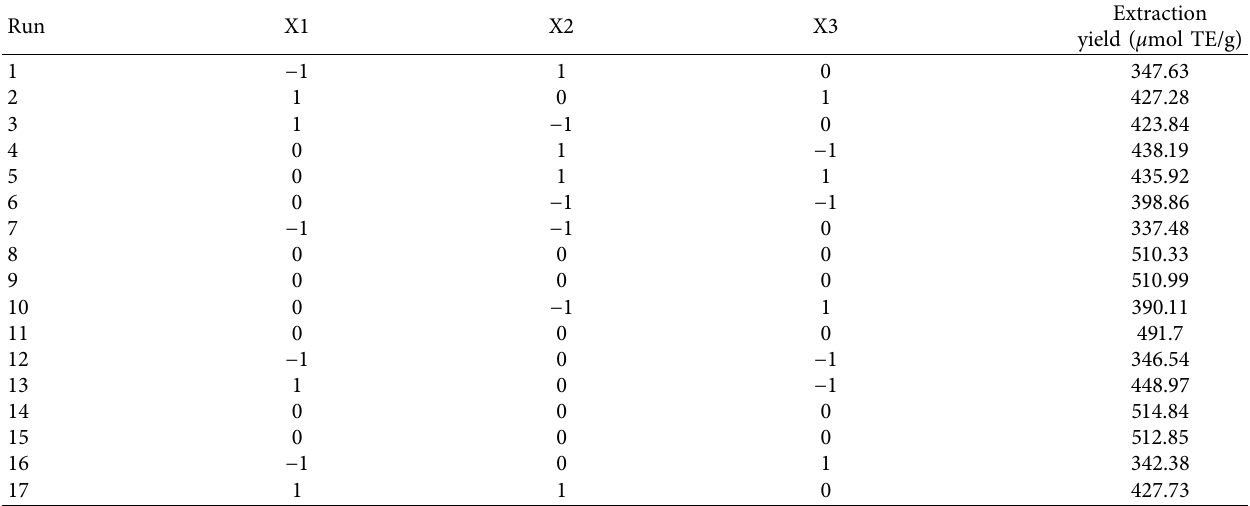
Table 2: Box–Behnken design and response data for antioxidants yields.